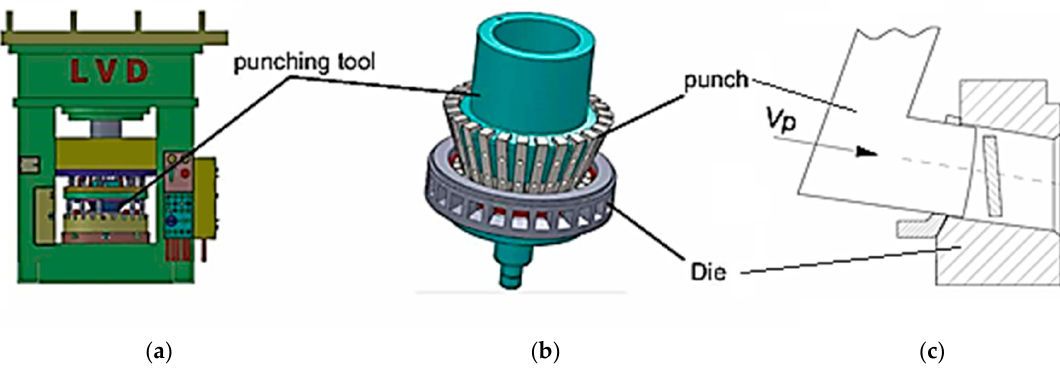
Figure 2. Achieving the windows in bearing cages: ( a ) LVD 600 hydraulic pressing equipment used for cutting the windows in bearings cages; ( b ) components of the cutting tool; ( c ) cutting of a window.